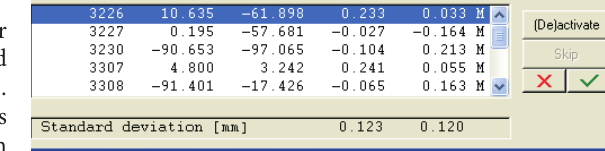
Fig. 6. A fragment of results taken from exterior image